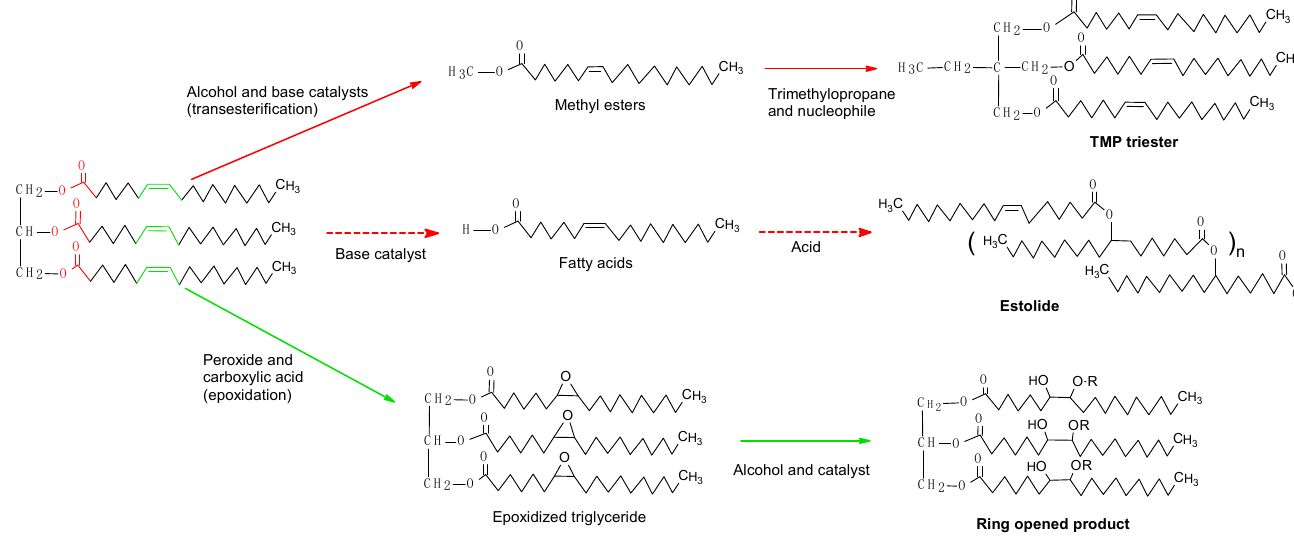
Figure 6. Reaction pathways for preparation of bio-lubricants.